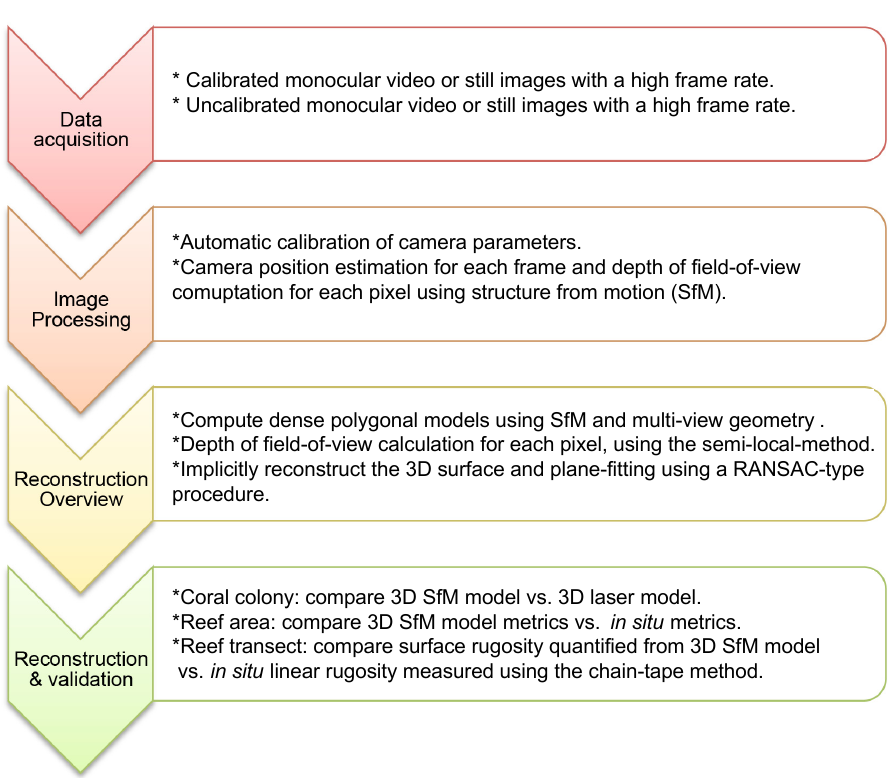
Figure 1. Processing modules and data flow for underwater 3D model reconstruction and validation process.